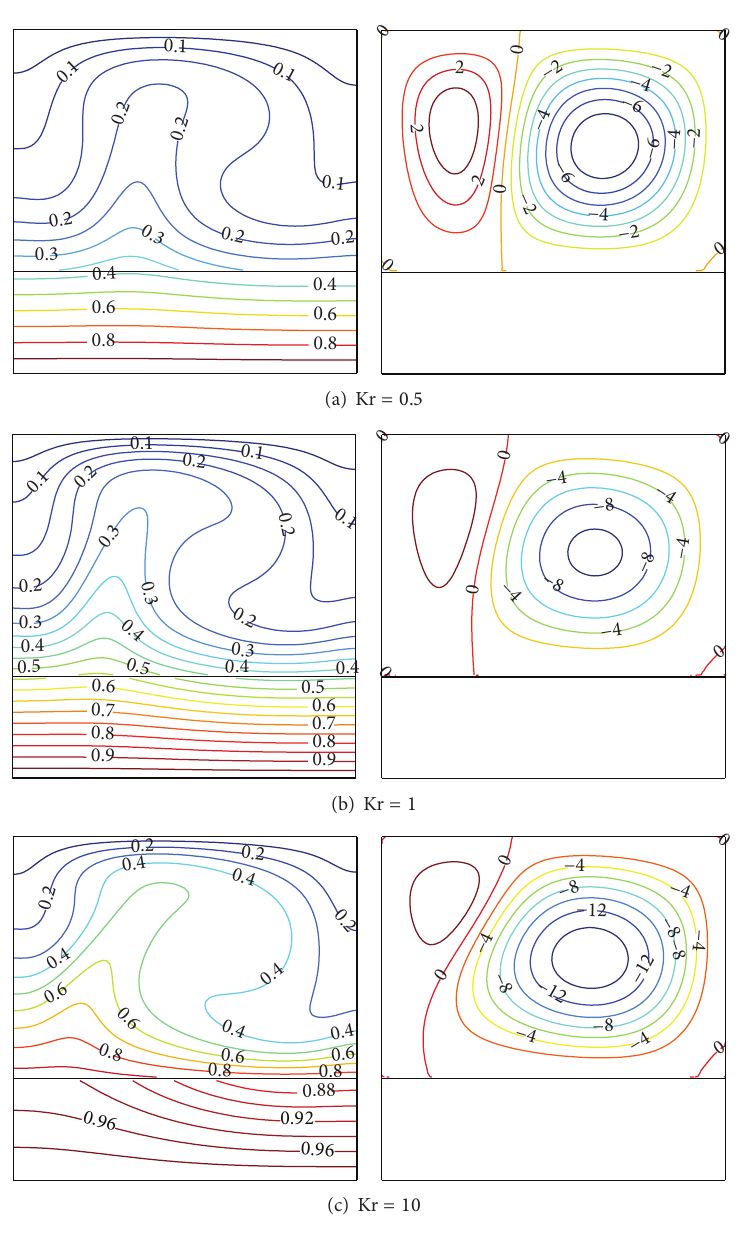
Figure 4: Isotherms (left) and streamlines (right) at Ra = 10 5 and 𝐷 = 0.3 .